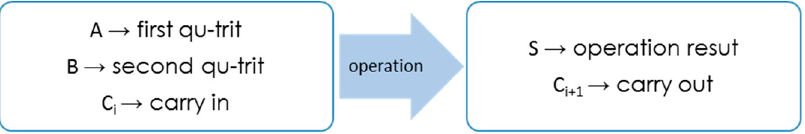
Figure 2. General arithmetic operation diagram in a qu-trit